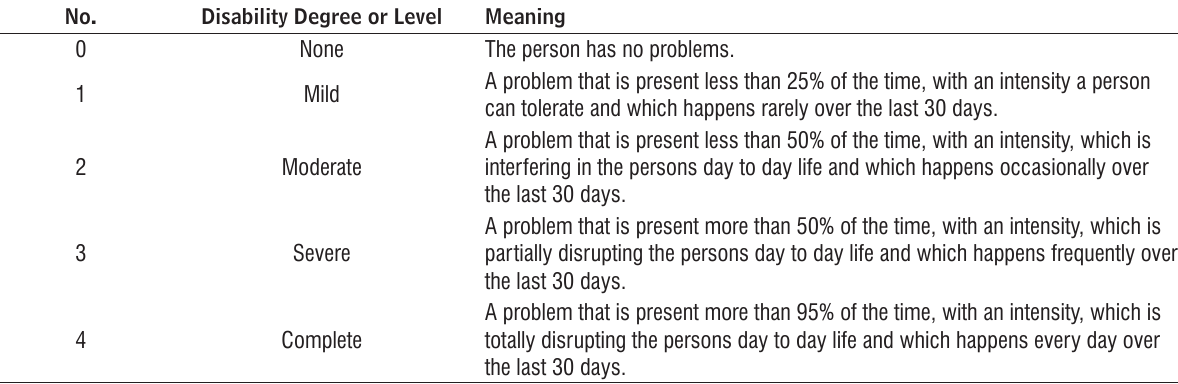
Figure 1 - Qualifying the extent of disability Note: Adapted from WHO,